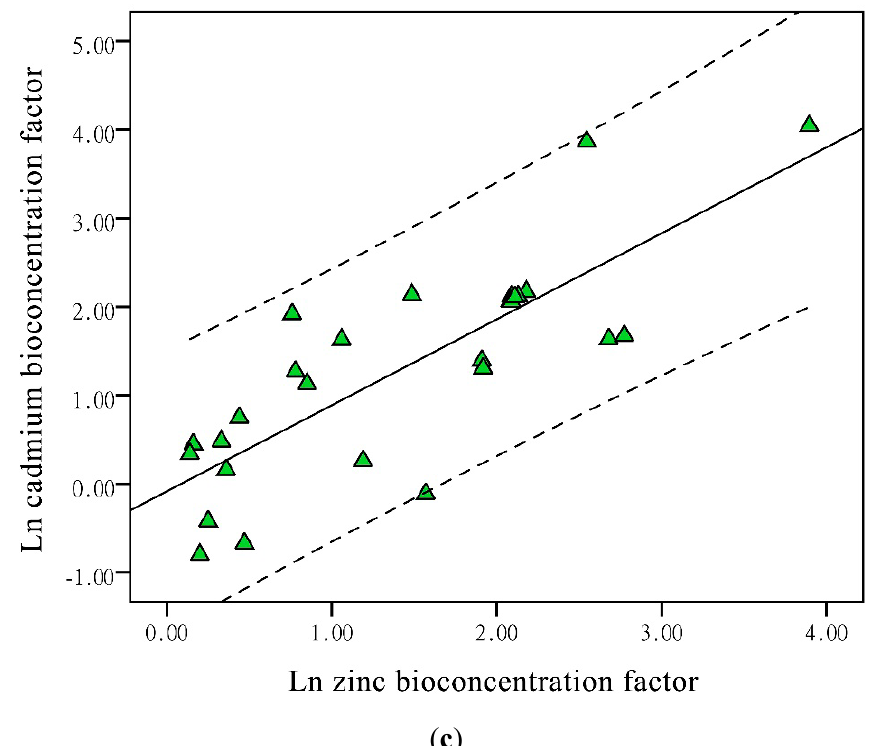
Figure 2. Correlations of bioconcentration factors between pairs of heavy metals ( a ) copper and zinc; ( b ) copper and cadmium; ( c ) zinc and cadmium.